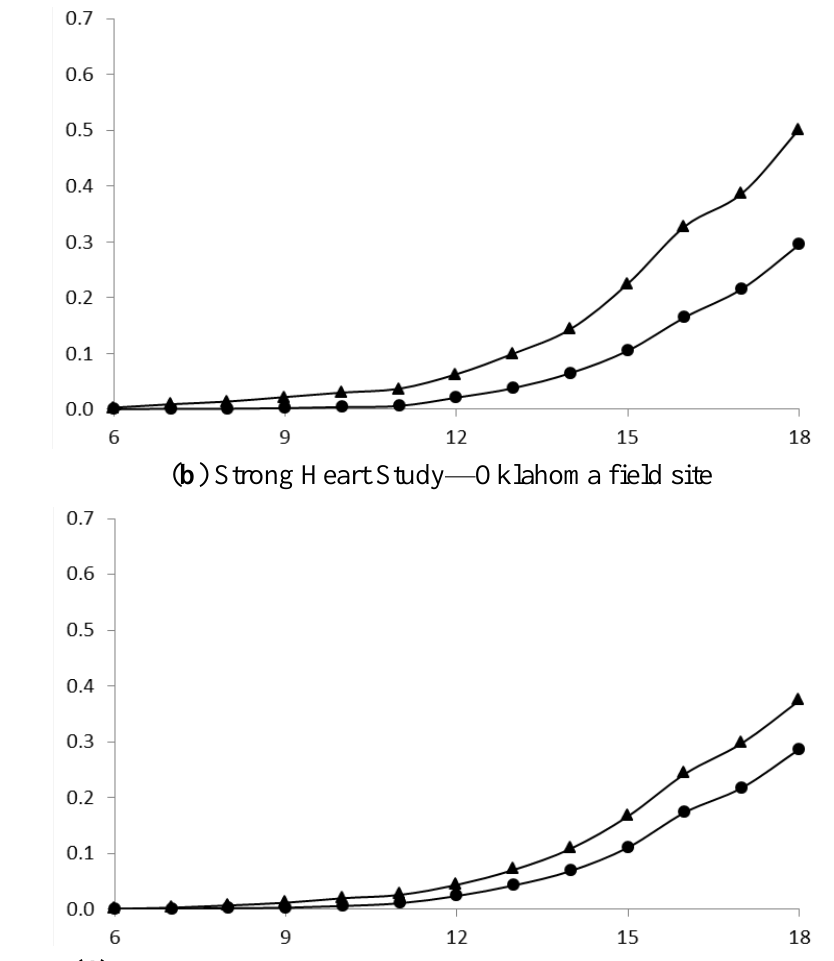
Figure 2. Cumulative incidence of smoking initiation across ages 6 to 18 years in American Indians from the Strong Heart Study and non-Hispanic whites from the National Health Interview Survey, stratified by